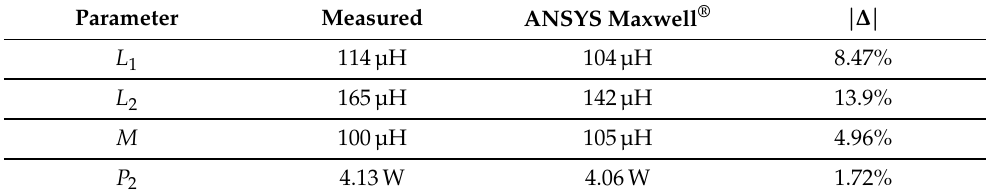
Figure 12. FEMM model of the small-size prototype realized in ANSYS Maxwell: rotary transformer with supports ( a ) and cores realized with C-shaped ferrites ( b ). Table 2. Measured vs. estimated transformer parameters. Supply frequency =